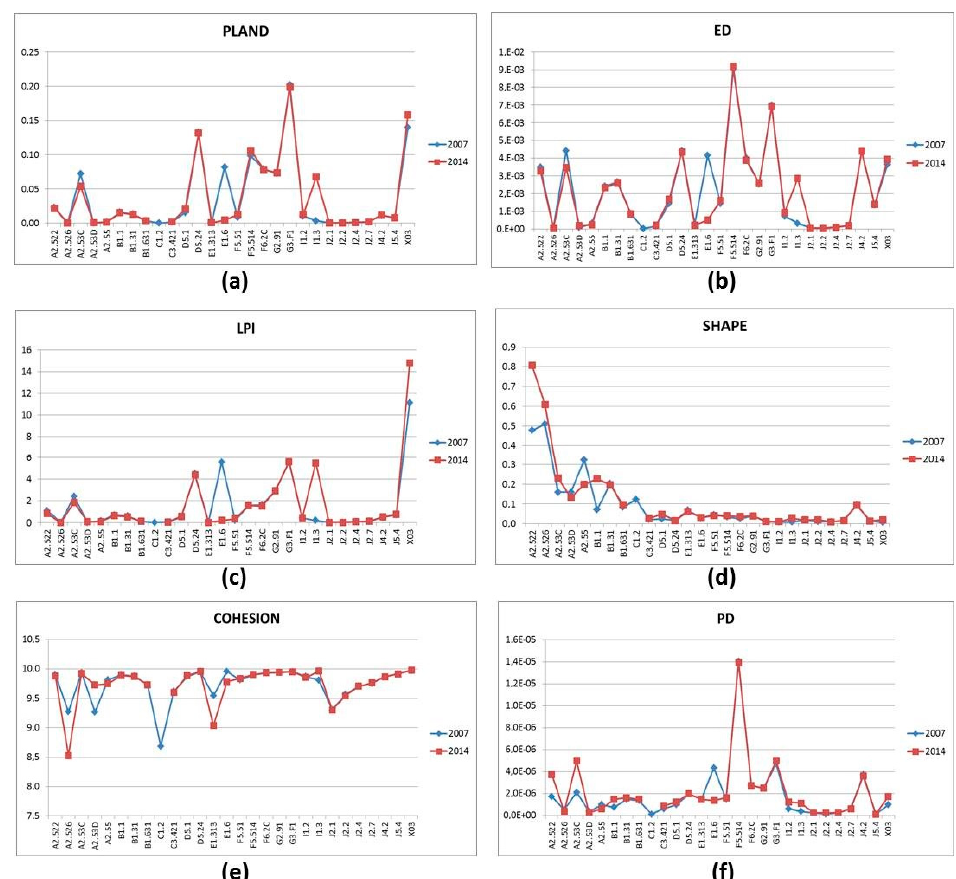
Figure 15. Diagrams comparing: ( a ) PLAND, percentage of landscape; ( b ) ED, edge density; ( c ) LPI, largest patch index; ( d ) SHAPE, mean patch shape ratio; ( e ) COHESION, patch cohesion index; and ( f ) PD, patch density at the CE site in 2007 and